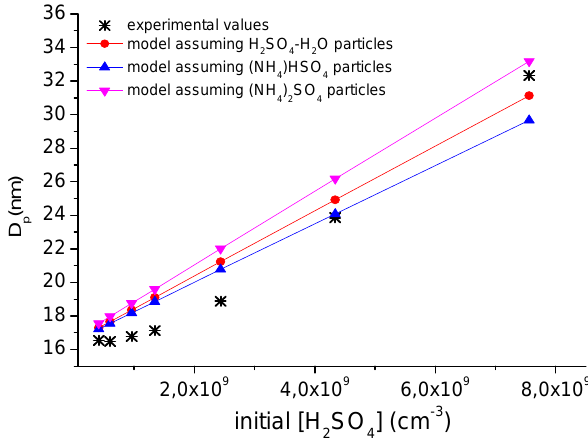
Figure 10. The comparison of the experimental median particle di- ameters determined from a measurement conducted at T = 283K, with an RH of ∼ 30% and a residence time of 90s, and the values predicted theoretically from a model using the initial H 2 SO 4 con- centration without a correction for wall losses. As can be seen, the model overestimates the growth rates slightly in the case of experi- ments conducted at a residence time of